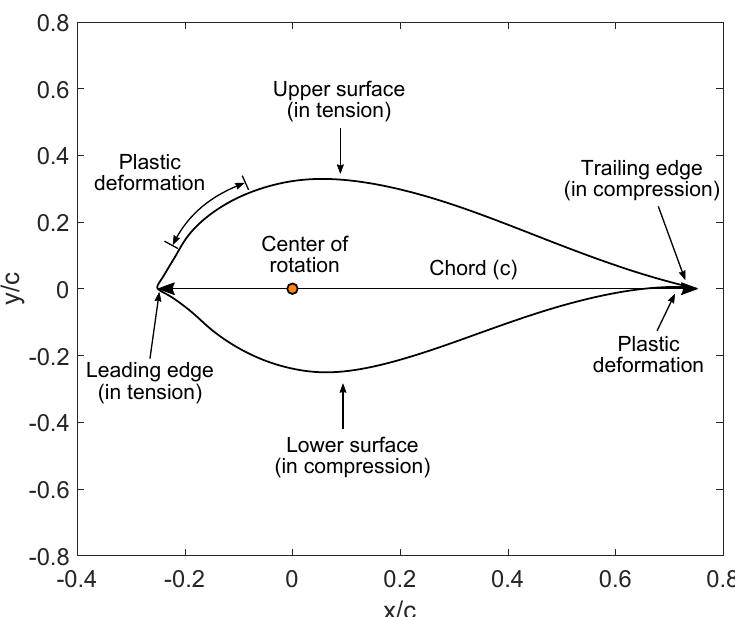
Figure 14. Graphical representation of the foil profile at r / R blade = 0.1 radial location.